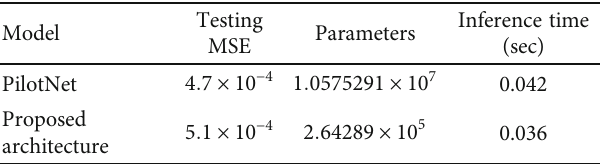
Figure 10: Modi fi ed PilotNet Table 3: Test mean squared error and parameters comparison between proposed architecture and PilotNet.